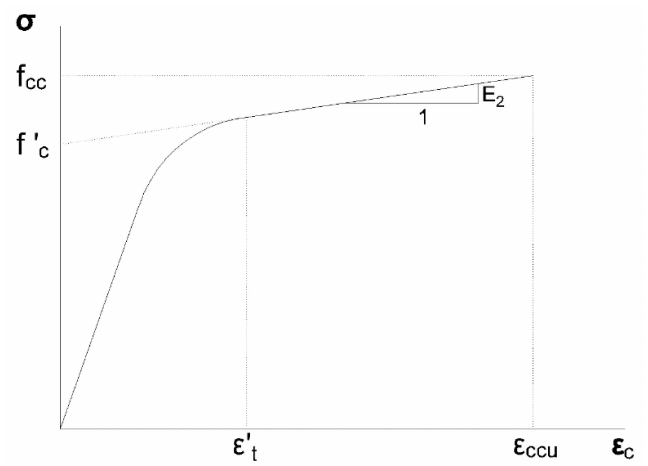
Figure 3. Stress-strain model for concrete confined with